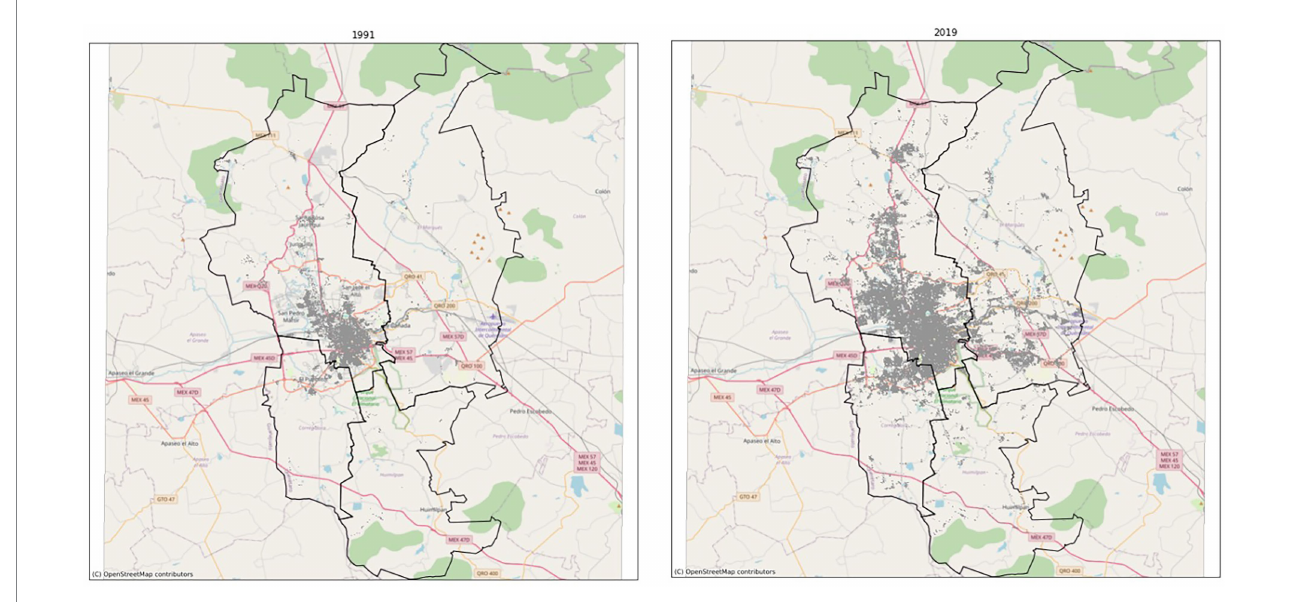
FIGURE 7 Urbanized area in the MAQ. Own elaboration.